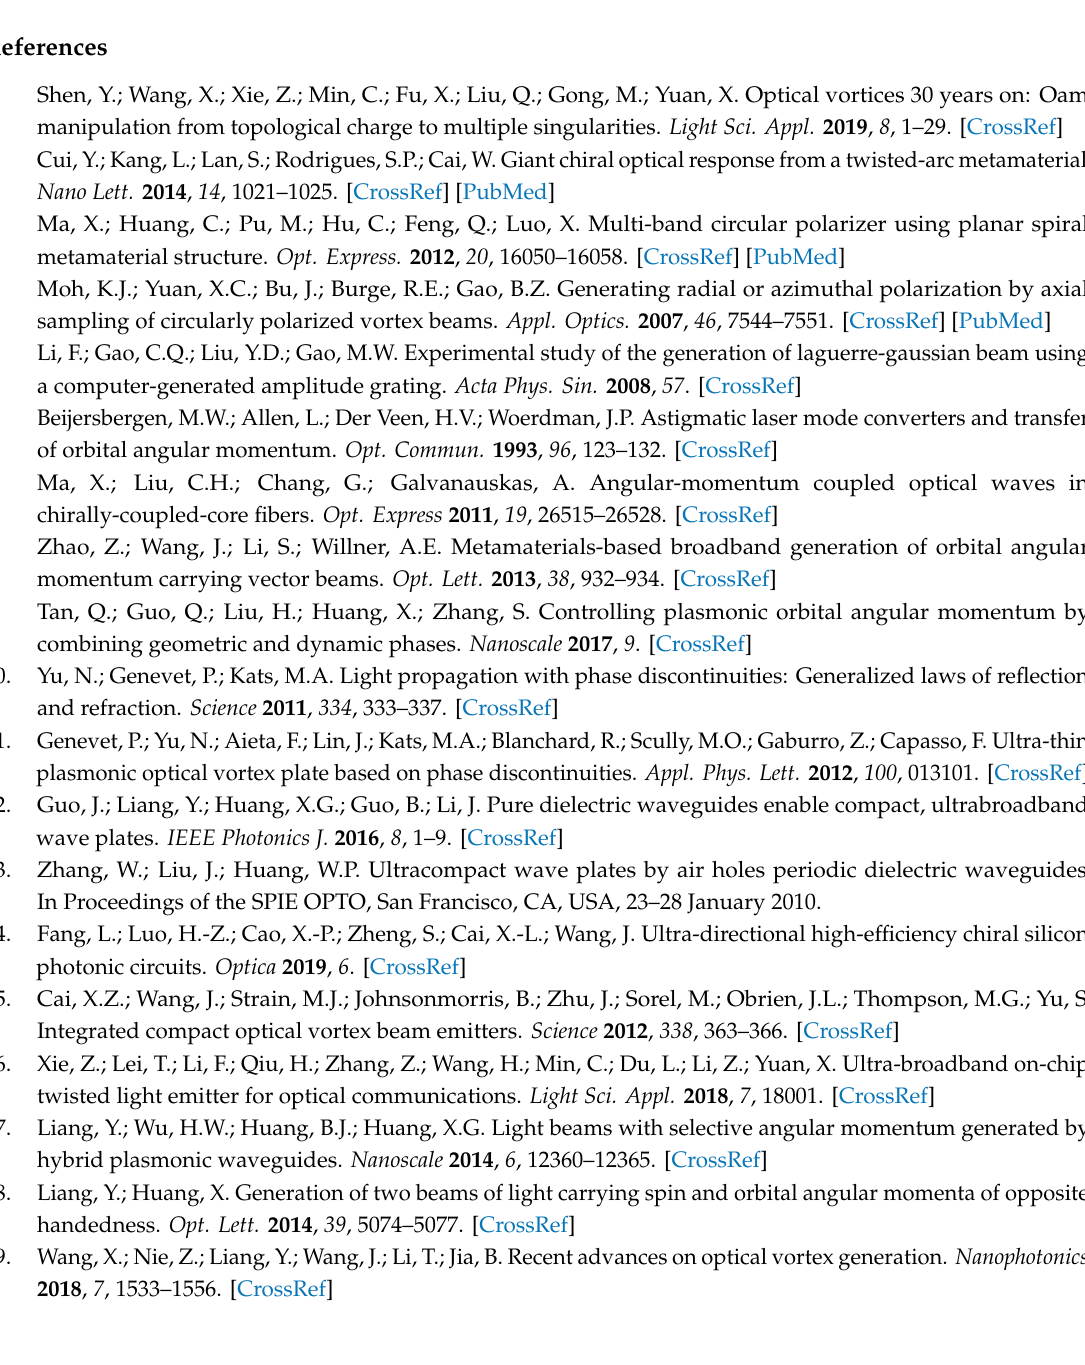
Figure S1: Fabrication process of the proposed graphene-based hybrid plasmonic